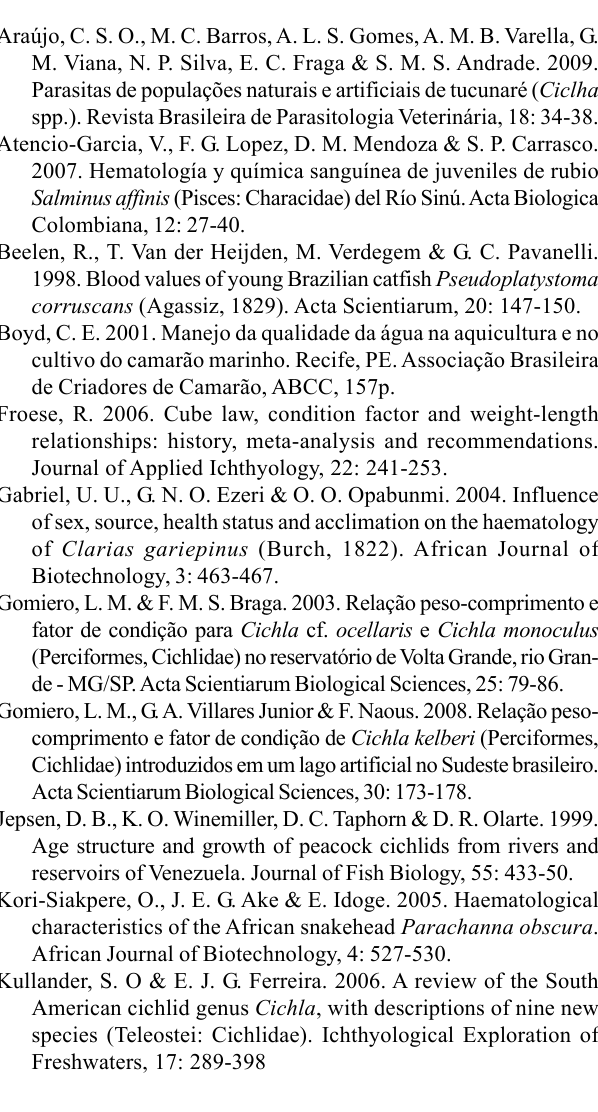
Piscine blood leukocytes are the major cell components